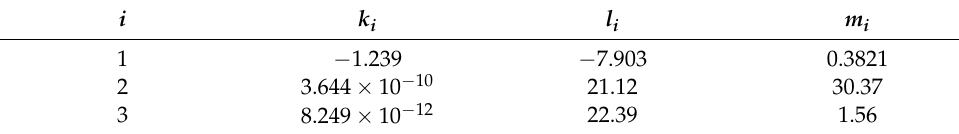
Table 1. Parameter set for the standard equilibrium potential taken from [28].